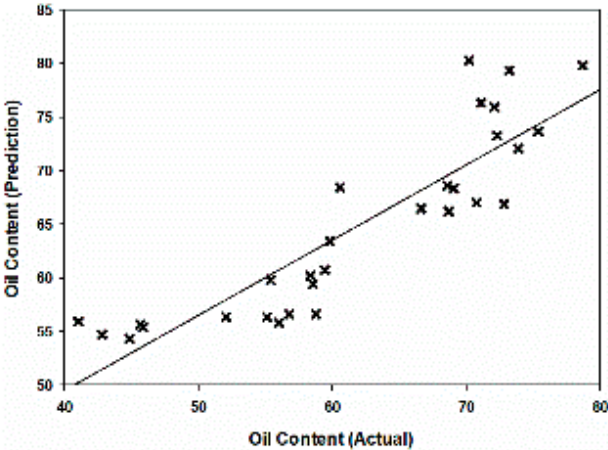
Figure 7. Relationship between actual and predicted oil content based on linear calibration model at 100 kHz.